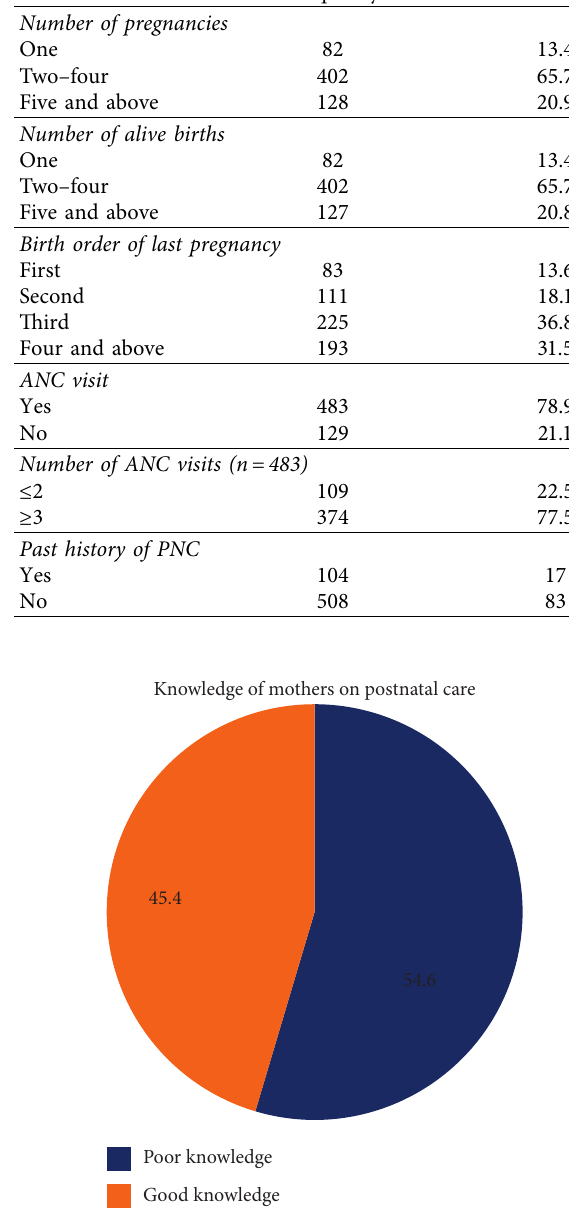
Figure 1: Knowledge about postnatal care utilization among mothers who gave birth in the last six months at Wonago District, South Ethiopia,